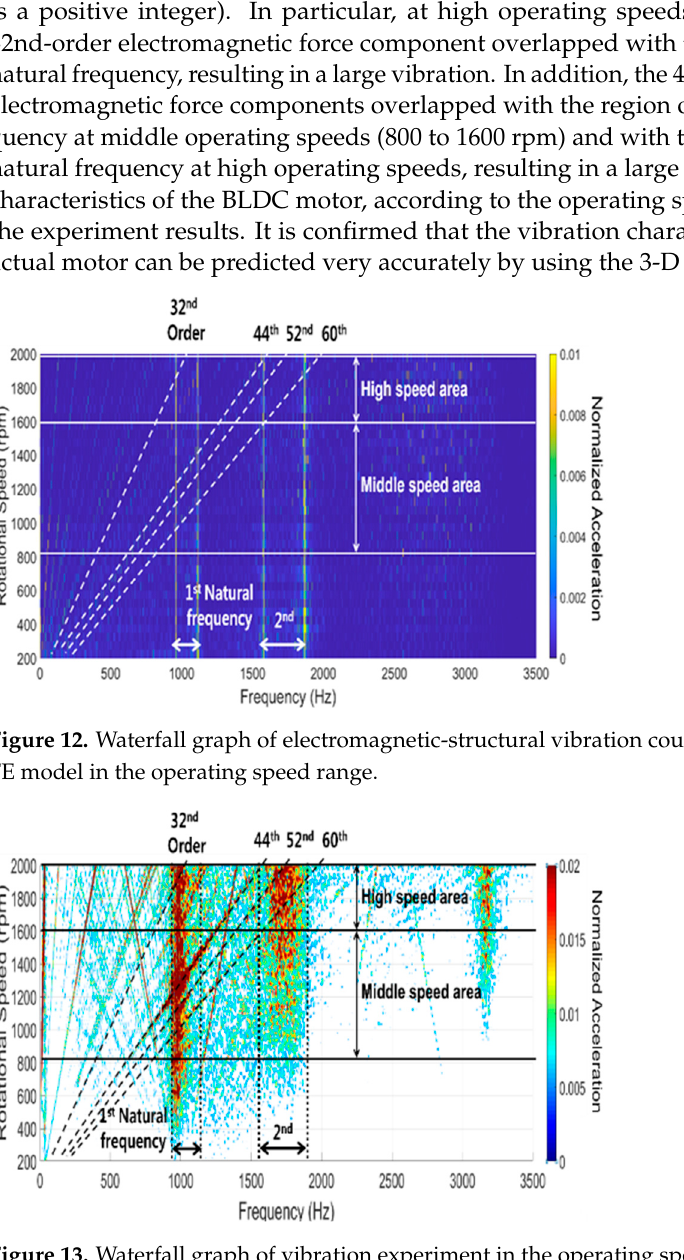
Figure 13. Waterfall graph of vibration experiment in the operating speed range.